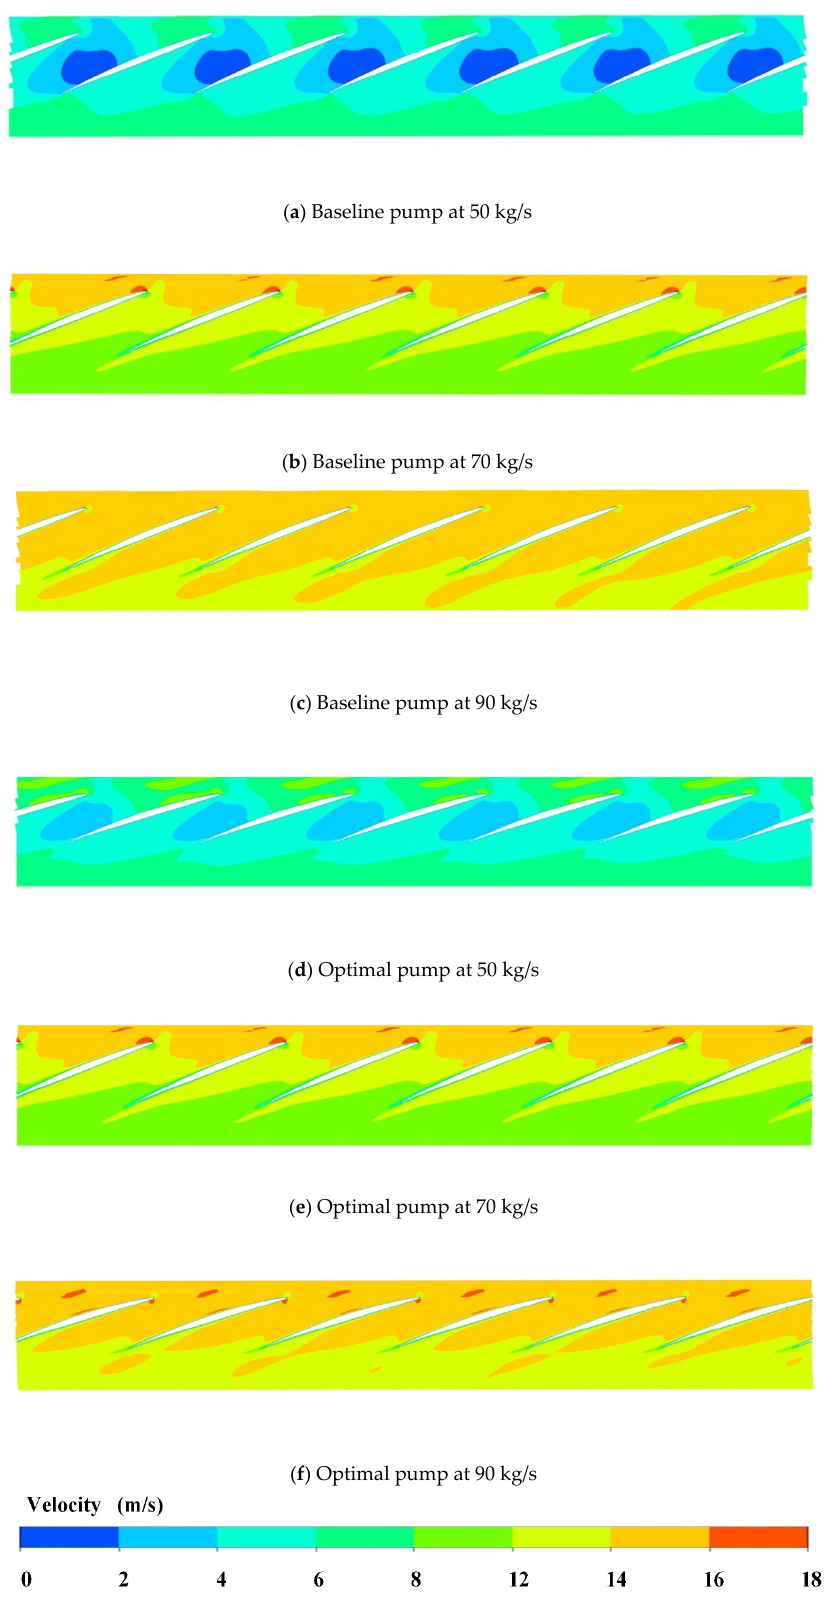
Figure 12. Velocity distributions of baseline pump and optimal pump.